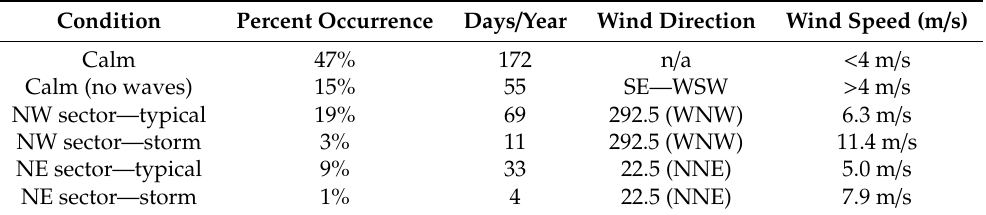
Table 6. Wind velocity forcing for modeled